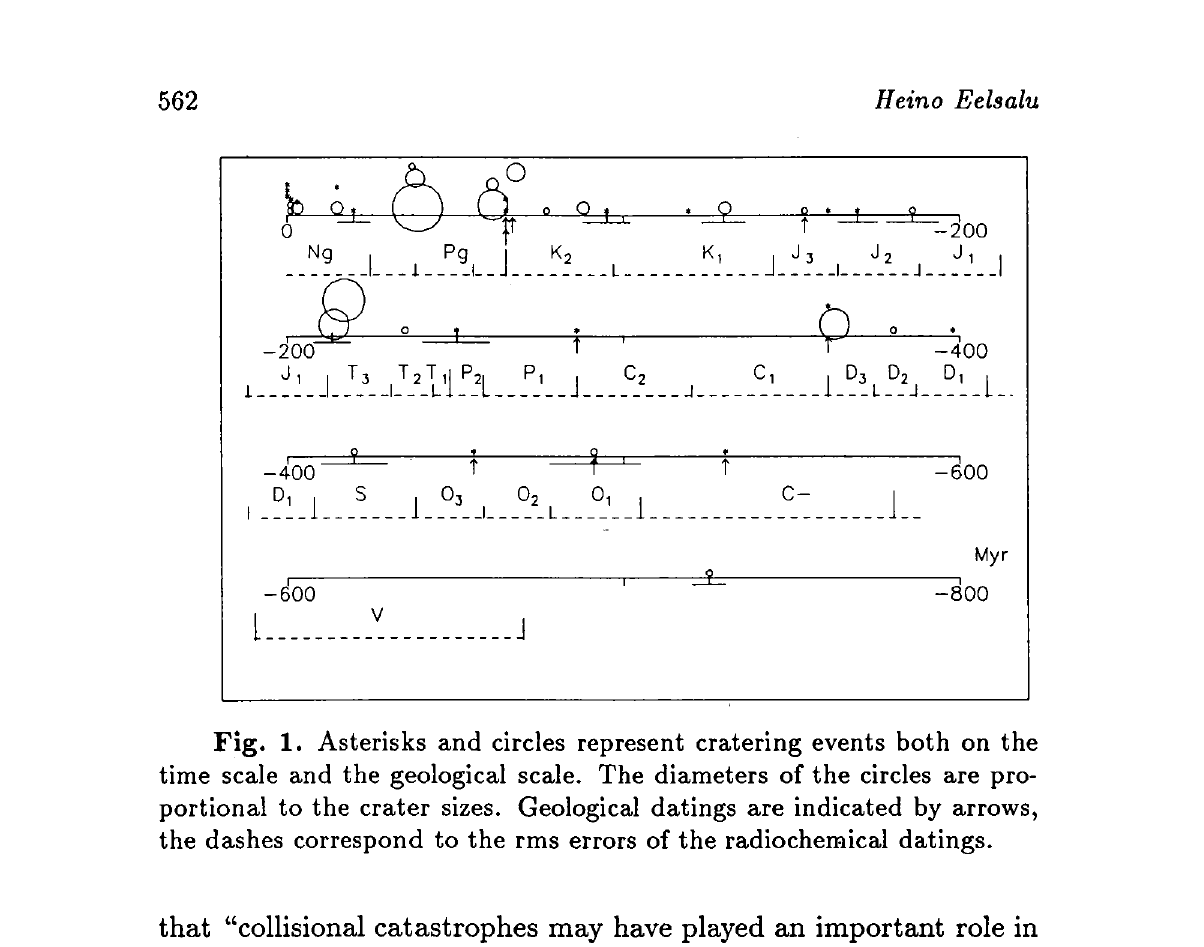
Fig. 1. Asterisks and circles represent cratering events both on the time scale and the geological scale. The diameters of the circles are pro- portional to the crater sizes. Geological datings are indicated by arrows, the dashes correspond to the rms errors of the radiochemical